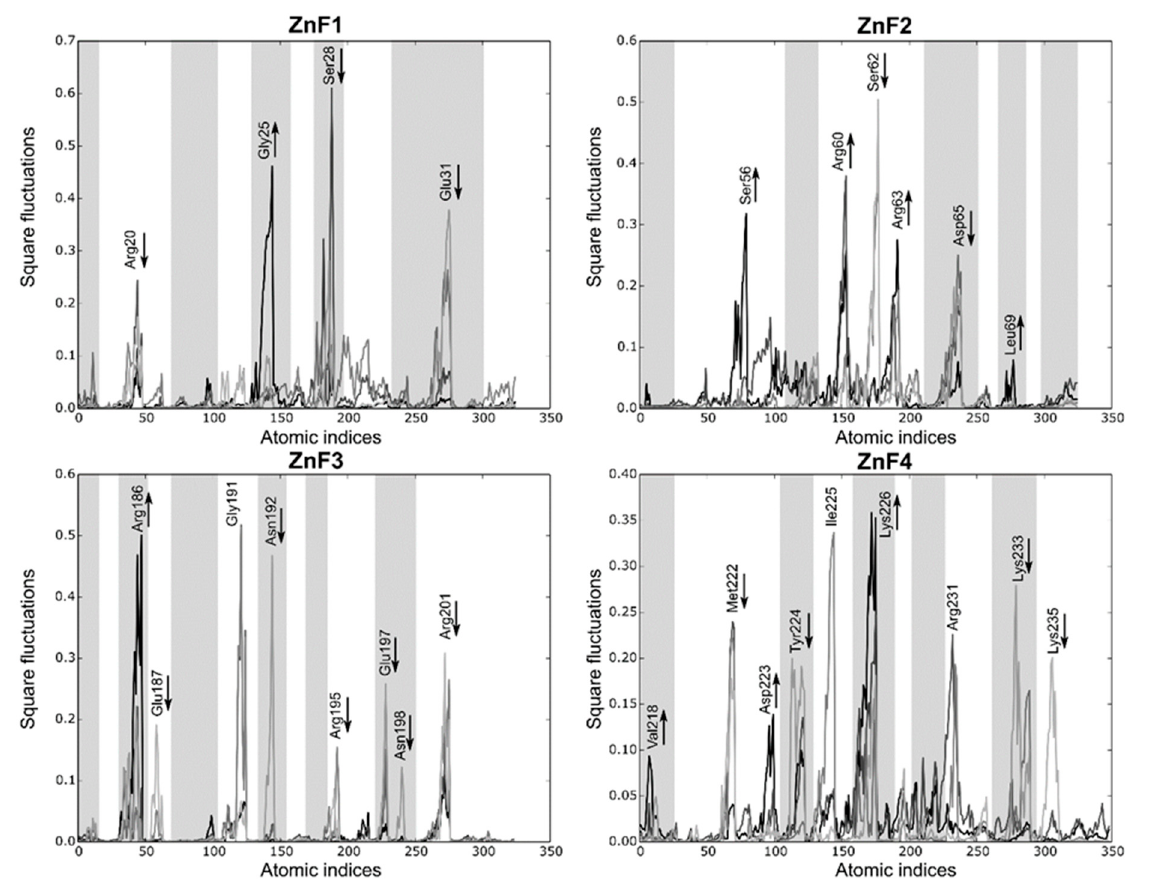
Figure 7. Local fluctuations extracted from the SMD simulations at four equally distributed segments of the trajectory. The binding process fluctuations (reversed SMD trajectory) are represented in light gray (unbound) to black lines (bound). Only the atomic indices of the RNA binding site are represented (ZnF1: 18 to 38; ZnF2: 52 to 72; ZnF3: 184 to 204; and ZnF4: 218 to 238). The most relevant fluctuations that increase or decrease during the binding process are indicated with an arrow. Grayed regions are not involved in the RNA-binding process.